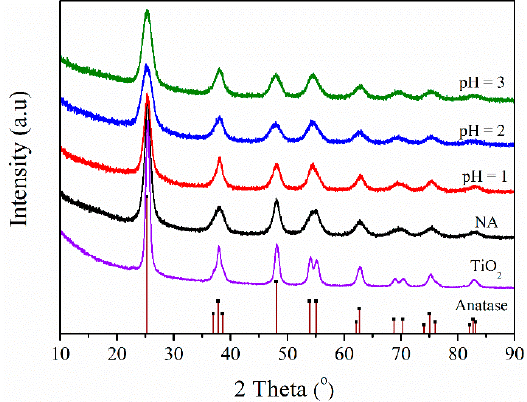
Figure 4. XRD patterns of different synthetic BFS ‐ TiO 2 samples and commercial TiO 2 .